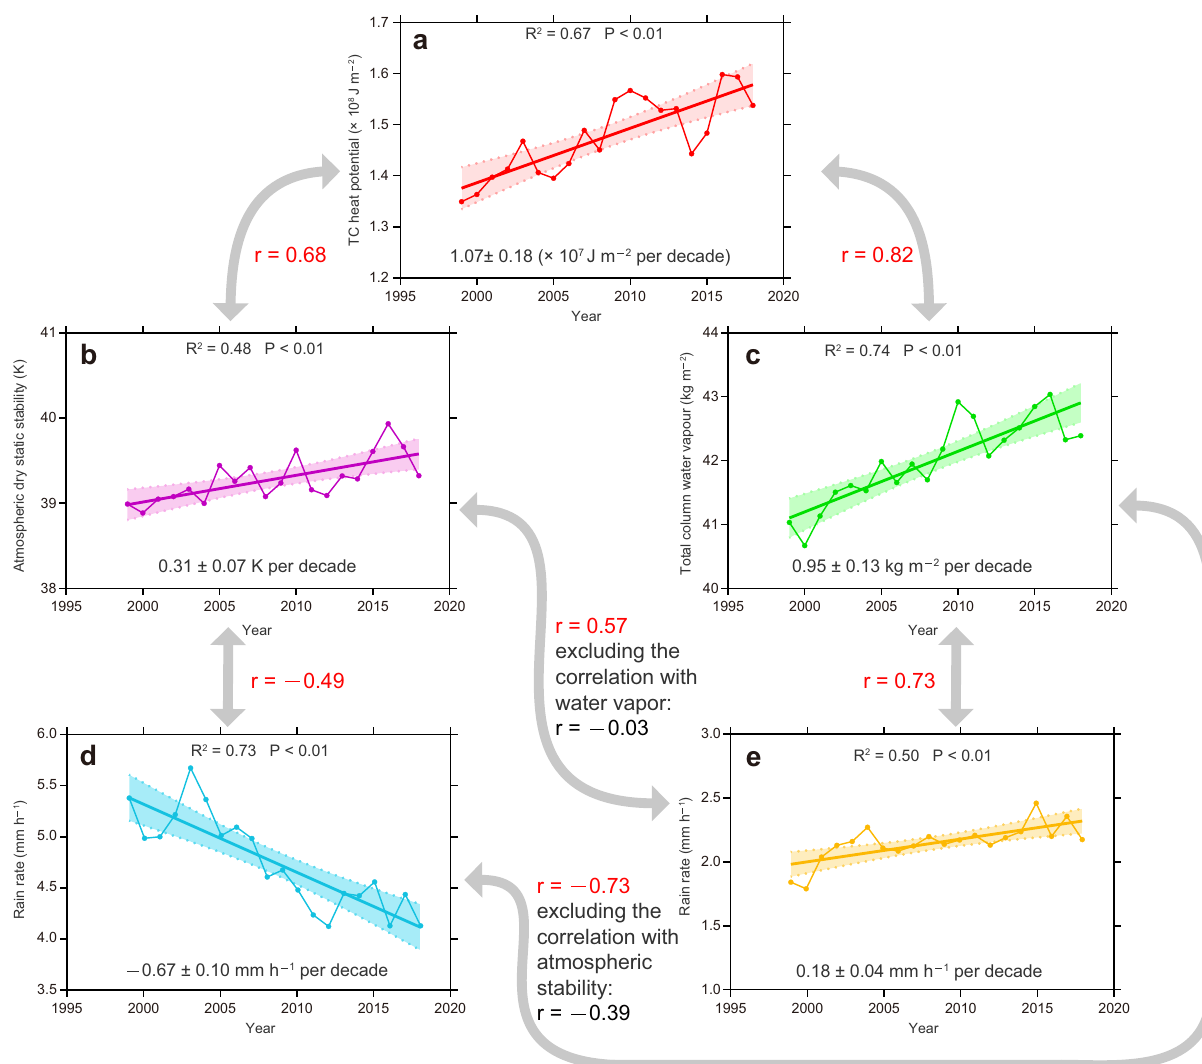
Fig. 3 Time series of the different parameters. a Tropical cyclone (TC) heat potential (TCHP), unit: ×10 8 J m − 2 . b Atmospheric stability, unit: K. c Total column water vapor, unit: kg m − 2 . Moreover, the annual global average rain rate (unit: mm h – 1 ) over, the d Inner- core, and e Outer region of TCs, respectively. The time series in a , b , and c are derived from an average of six ocean basins during the TC peak seasons (Western North Paci fi c: 120° E – 180°,5 – 30°N, May – December; Eastern North Paci fi c: 120 – 90°W,5 – 30°N, June – October; North Atlantic: 90 – 20°W,5 – 30°N, June – October; South Indian Ocean: 50 – 115°E,5 – 30°S, November – April; South Paci fi c: 155°E – 180°,5 – 30°S, December – April; North Indian Ocean: 55 – 90°E,5 – 30°N, April – May and September – November). The shading area in all fi ve panels indicate the two-sided 95% con fi dence levels of the trends, and the bold lines represent the linear regression. The r is the correlation coef fi cients of the two parameters indicated by the gray arrows, red signi fi cant and black insigni fi cant. The rain rates in d & e are constructed using the Tropical Rainfall Measuring Mission (TRMM) Multi-Satellite Precipitation Analysis (TMPA) dataset. All of the linear trends are signi fi cant at 95% con fi dence